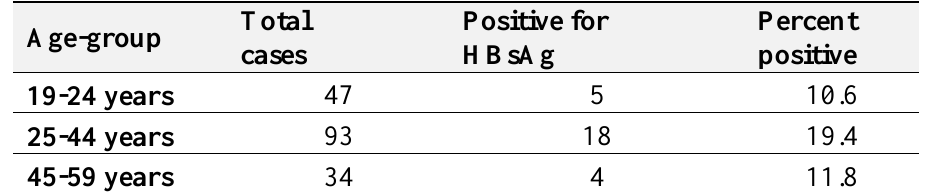
Table 2. Testing results by age